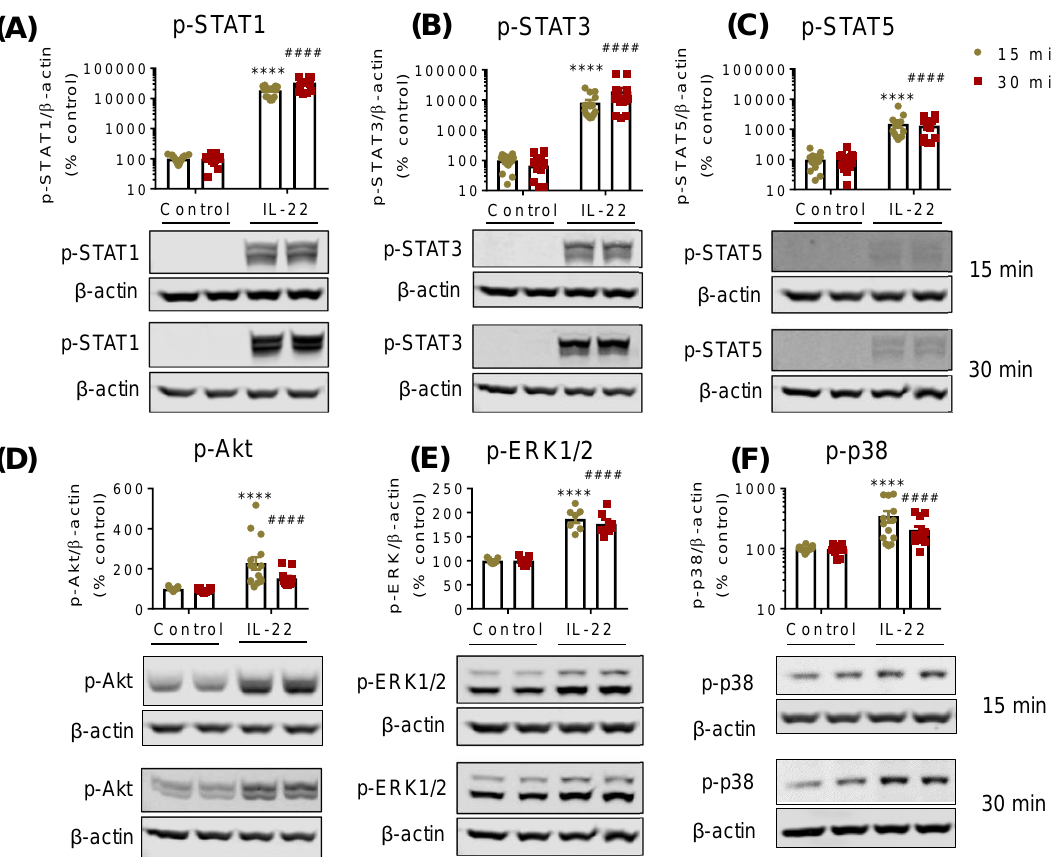
Figure 2. IL-22-activated signalling pathways in intestinal epithelial LS174T cells. Following IL-22 treatment for 15 or 30 min cells were lysed and Western blotting was performed to detect IL-22-induced phosphorylations of ( A ) STAT1, ( B ) STAT3, ( C ) STAT5, ( D ) Akt, ( E ) ERK1 / 2, and ( F ) p38 in LS174T cells. Data are presented as mean ± SEM with individual cultures ( n = 13 from four independent experiments). **** p < 0.0001 compared with 15 min control and #### p < 0.0001 compared with 30 min control (nonparametric Man-Whitney t